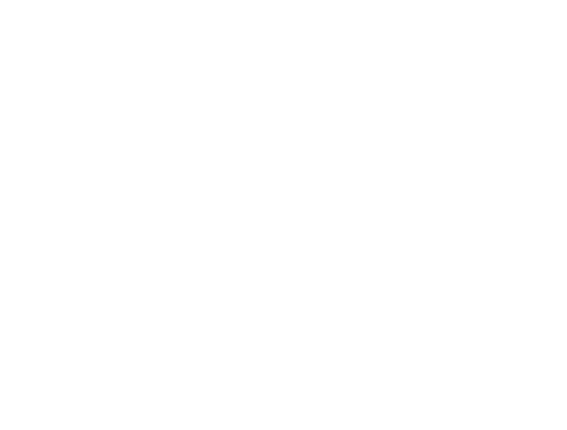
Fig. 1: Generalized abdominal distention of the patient.